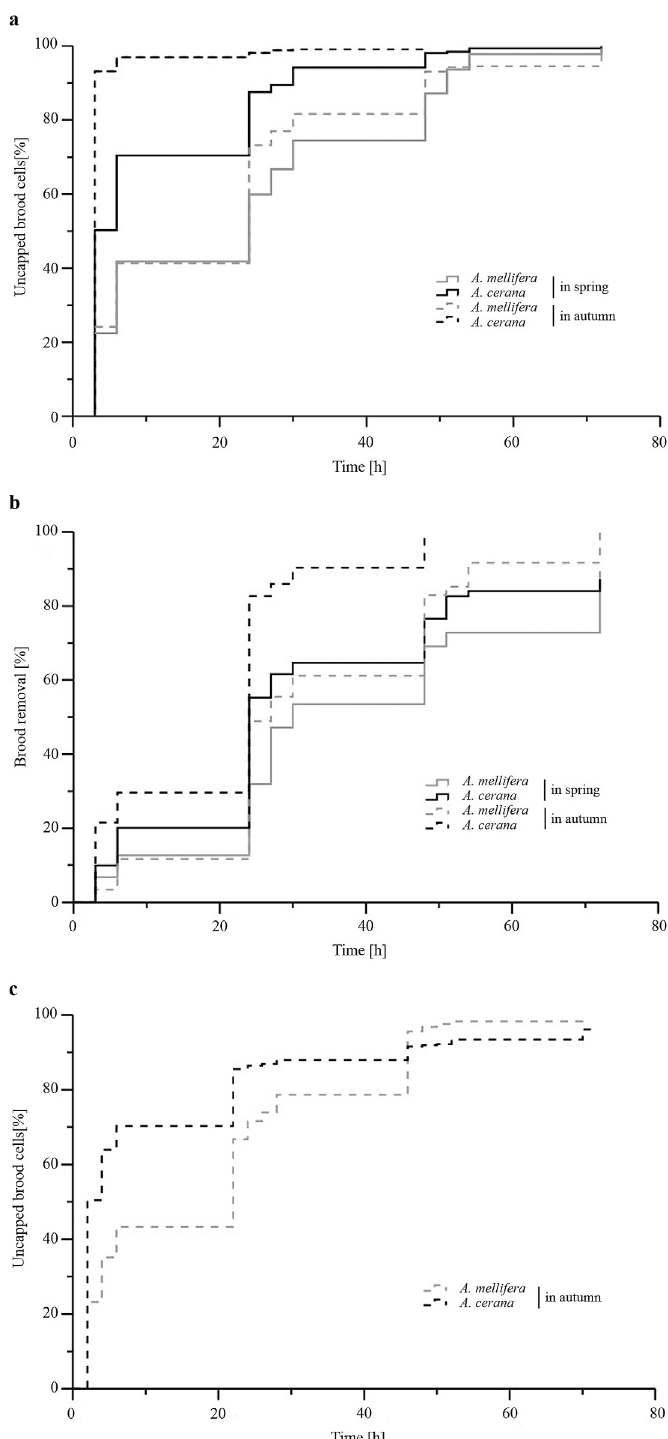
Fig 1. Uncapping of freeze-killed brood cells and brood removal over time in colonies of Apis mellifera and A . cerana . Kaplan-Meier plots are shown for cell uncapping (a) and brood removal (b) in Langstroth hives, as well as for cell uncapping in observation hives (c). For consistency with the text, we express the percentage as an increase in brood targeted by hygienic behavior instead of displaying brood survival based on the decreasing percentage of cells remaining capped. The percentage of brood uncapped or removed at